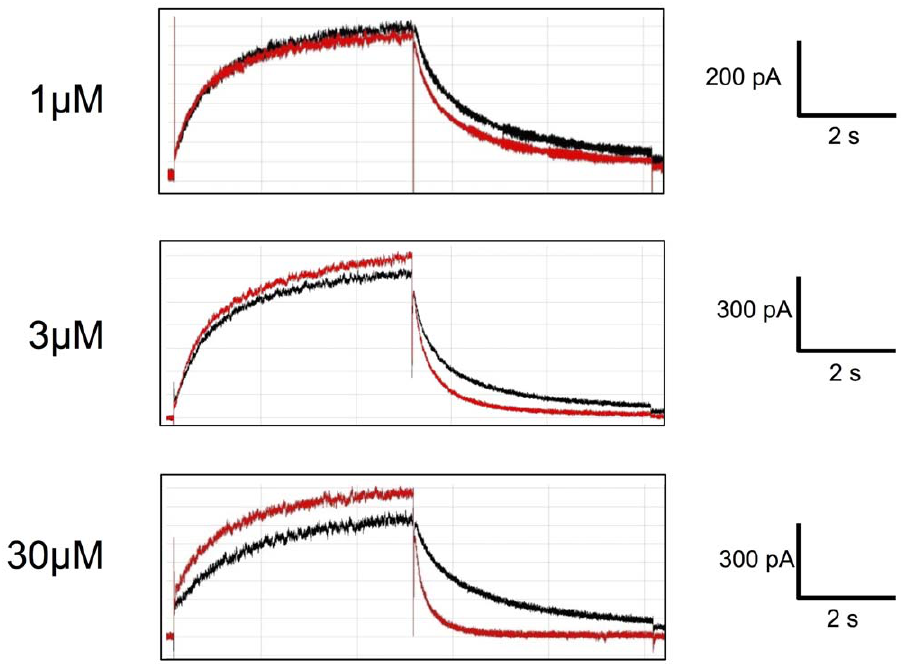
Figure 3. Concentration-dependent acceleration of I hERG inactivation induced by C18-CAR. The records were obtained in 3 different cells. The current obtained in presence of C18-CAR is shown in red.